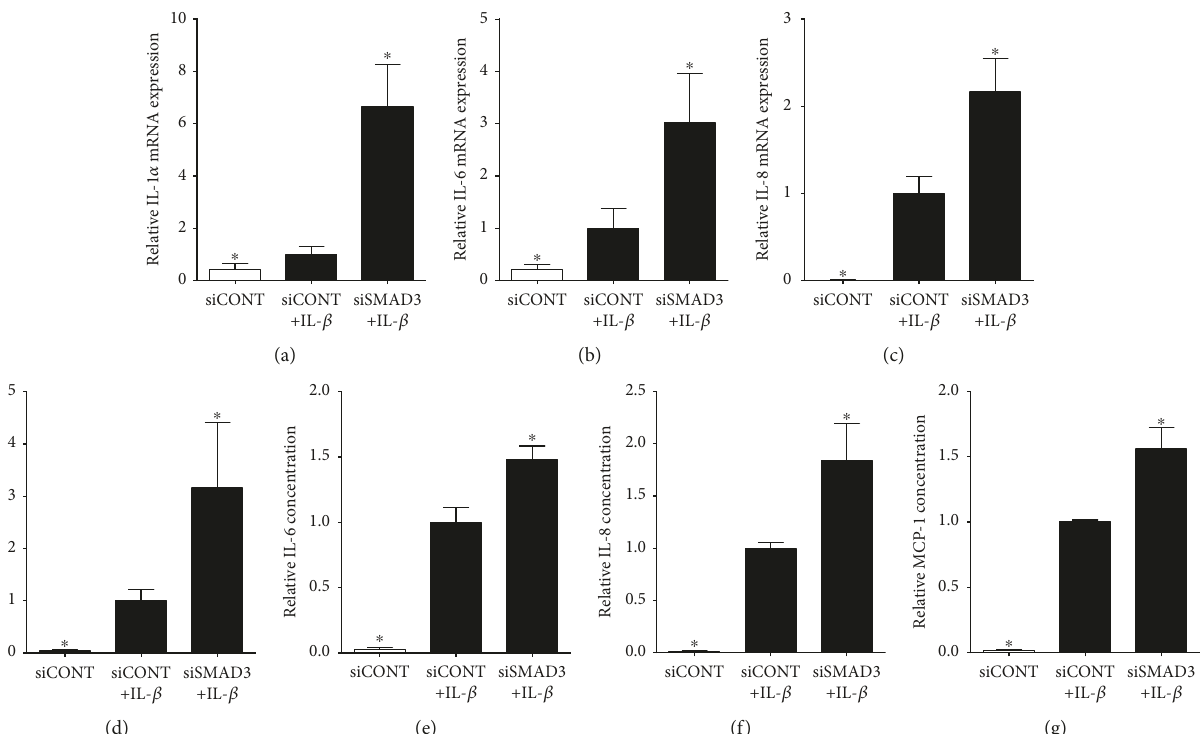
Figure 3: E ff ect of siSMAD3 on IL-1 β -induced proin fl ammatory cytokines and chemokines. Human primary myometrial cells, obtained from women at term in the absence of labour, were transfected with or without 50nM siSMAD3 or 50nM siCONT for 48h and then treated with 1ng/ml IL-1 β for an additional 24h ( n = 5 patients). (a – d) Expression of IL-1 α , IL-6, IL-8, and MCP-1 mRNA was analysed by qRT-PCR. (e – g) IL-6, IL-8, and MCP-1 concentrations in the incubation medium were assayed by ELISA. For all data, the fold change was calculated relative to IL-1 β -stimulated siCONT-transfected cells and displayed as mean ± SEM. ∗ P ≤ 0 05 vs. IL-1 β -stimulated siCONT-transfected cells (one-way